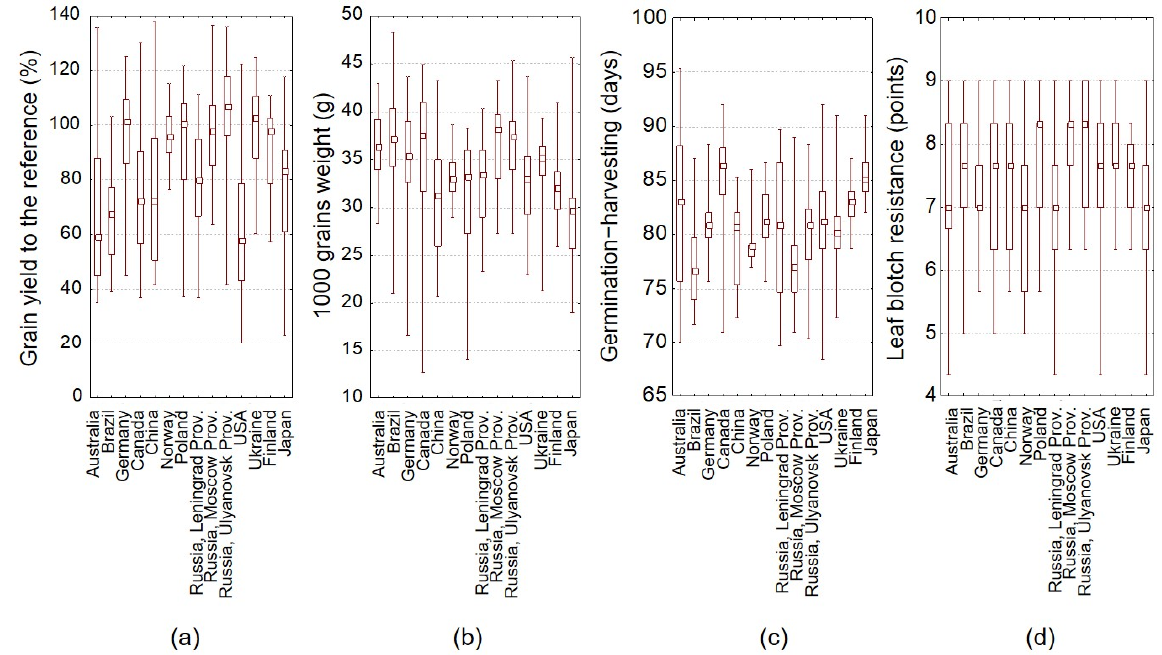
Figure 4. Useful agronomic traits in the large groups of accessions classified according to their geographic origin: ( a ) grain yield, percentage of the reference level; ( b ) 1000 grain weight; ( c ) germination to harvesting period; ( d ) leaf blotch resistance. Means, quartiles, and minimum/maximum values are shown.